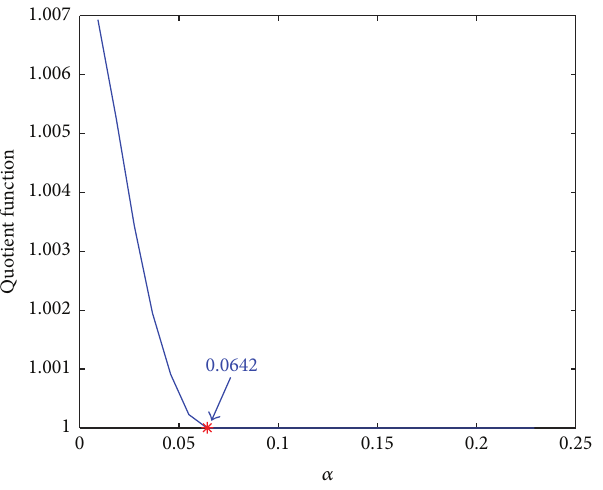
Figure 21: QF in experiment of SISO system.